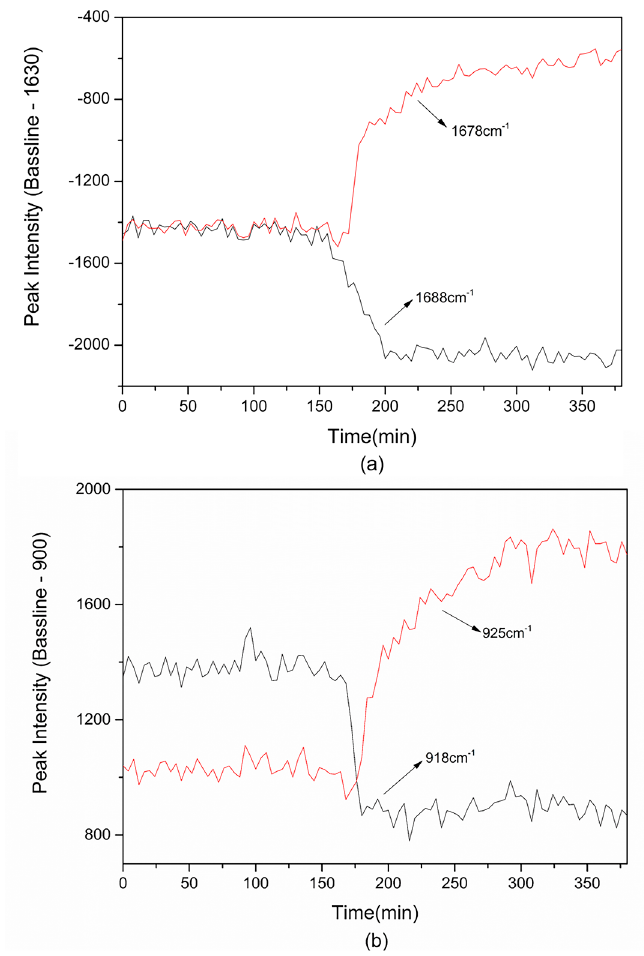
Figure 7. The relative peak intensity during TP-BA cocrystal formation in cooling crystallization: ( a ) 1678/1688 cm − 1 ; ( b ) 918/925 cm − 1.